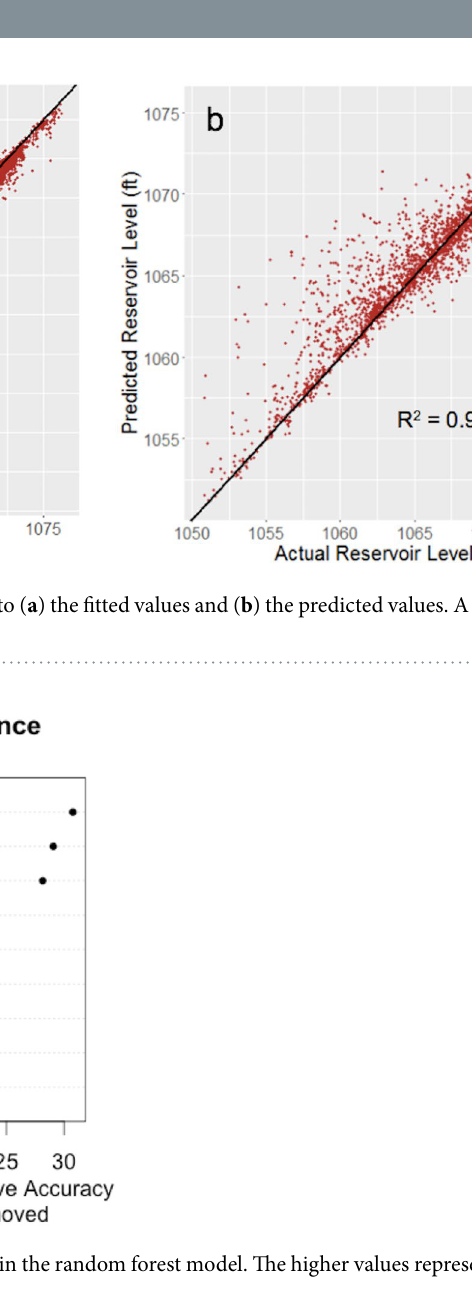
model would perform the best. In addition to having a small error, which demonstrated high predictive accuracy, the random forest model also had a high goodness-of-fit, as demonstrated in Fig. 1. This figure shows the actual reservoir levels plotted against the fit of the training data (a) and the predicted values of the test data (b), with a 45° line for reference. Variable importance in the random forest model. In addition to knowing which model performs the best, it is important to understand which predictors are contributing the most to the predictive accuracy. That is, which predictors most greatly affect the reservoir level. Variable importance is measured by ranking the predic- tors based on their contribution to the out-of-sample accuracy. That is to say, the larger the decrease in accuracy after the removal of a predictor, the more important that predictor is to the final model. As shown in Fig. 2, the most important variables were the streamflow (into the reservoir), dew point temperature, and population, fol- lowed by soil moisture and the El Niño/Southern Oscillation (ENSO) index. Conversely, precipitation was the least important variable when trying to predict reservoir level. Therefore, one could remove precipitation from the model and not lose significant predictive accuracy. In fact, the predictive performance of the model may increase, since the removal of an unrelated variable will reduce the complexity of the model and improve the bias-variance trade-off.